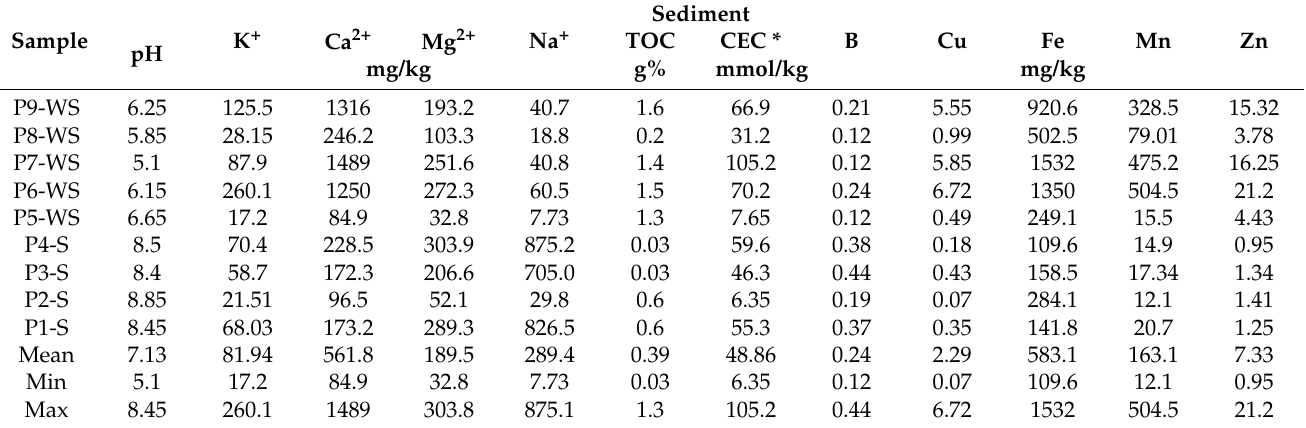
Table 5. Main chemical features of sediment samples of Para í ba do Sul